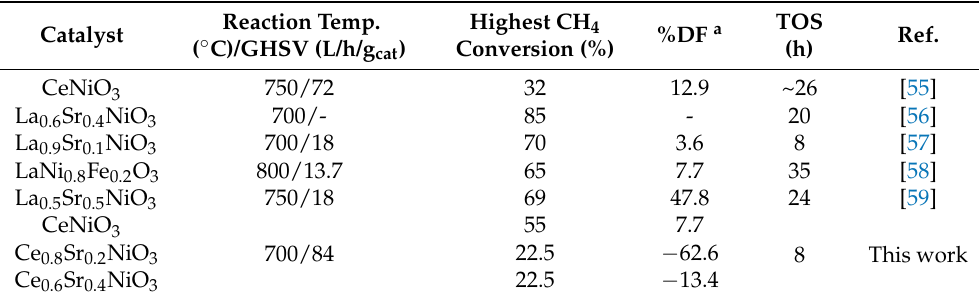
Figure 8. Schematic diagram of the reaction mechanism over Sr-free and Sr-incorporated perovskites. Table 2. Comparison of current work with previously reported work. DF refers to deactivation factor. TOS indicates